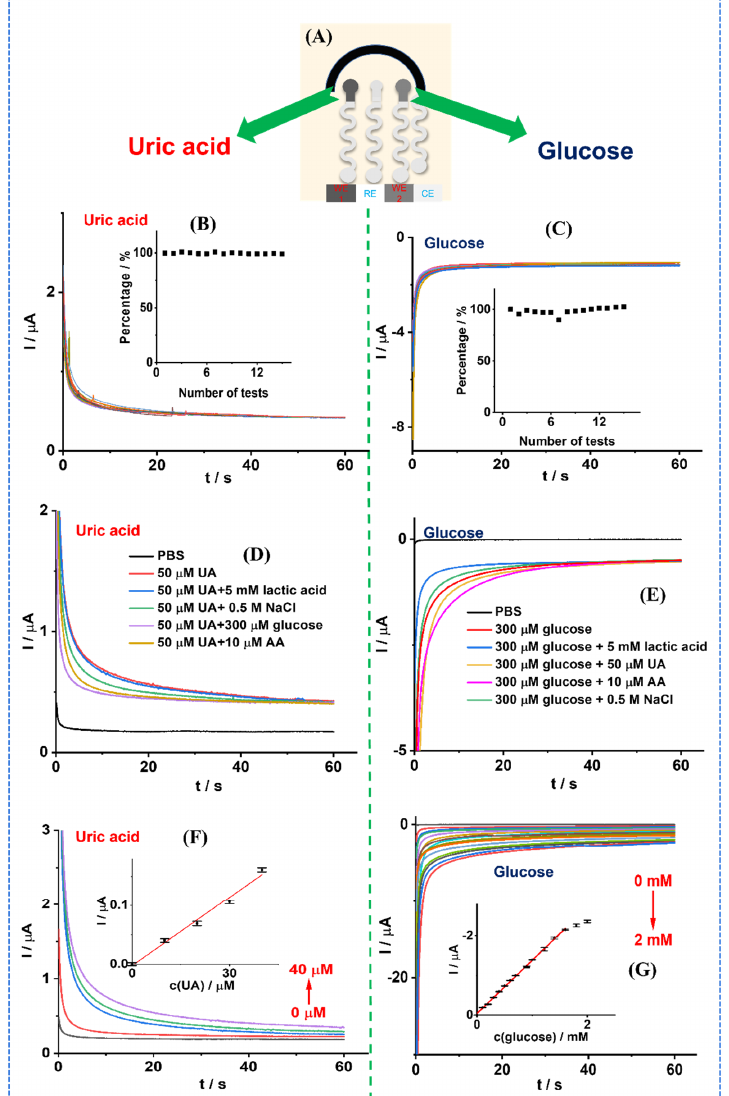
Figure 5. The stability, selectivity, and real sample sensing of the dual-function wearable electro- chemical sensor. ( A ) Schematic of the sensor’s design. ( B , C ) The stability of the sensor for UA and glucose sensing by chronoamperometry for 60 s, respectively. The insets plot the degree of response attenuation of 15 tests compared to the 1st chronoamperometric response. ( D , E ) The selectively test of the dual sensor for UA and glucose sensing, respectively. The common interfering species and their corresponding concentrations in physiological conditions are listed in the Figure. ( F , G ) The dual function sensor’s real sample test for UA and glucose in sweat, respectively. The insets show the relationship of response current against the concentration, and the linear fitting curves are plotted, respectively. n =